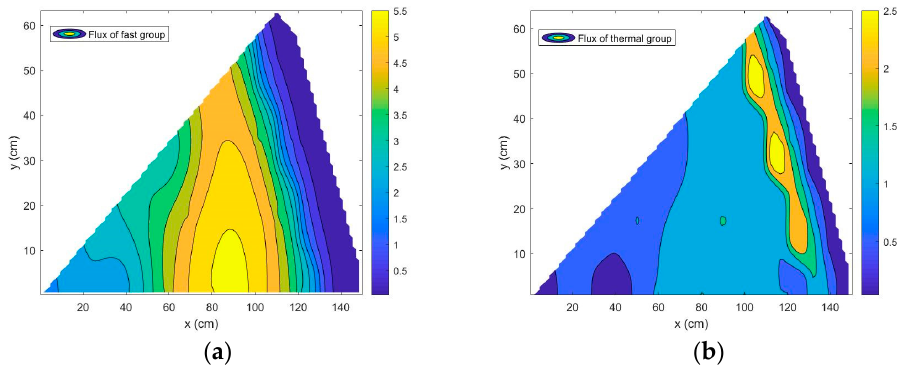
Figure 14. Relative flux distribution of 1/12 Core (( a ) fast group and ( b ) thermal group).